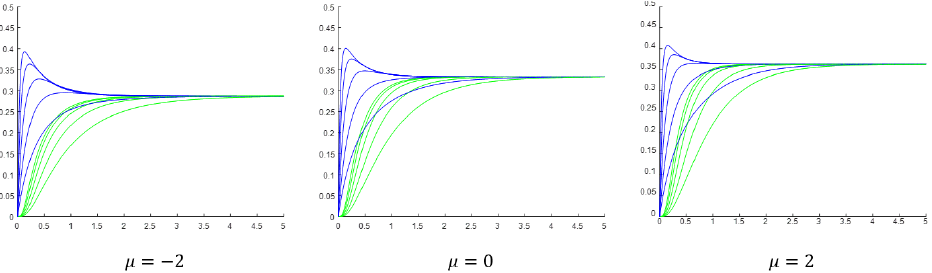
Figure 6. The dimensionless heat flux through the contact surface liquid–solid-body (blue) and through the right boundary (green) as a function of the time 𝜏 for Bi = 1 , a fixed ratio of 𝜏 𝑎 /𝜏 𝑐 = 1 , and 𝜏 𝑎 = 1, 1/2,1/4, 1/8,1/16 (the top blue and the top green curves correspond to 𝜏 𝑎 = 1/16 ). The thermal conductivity is 𝑔(𝜃) = 𝑒 𝜇𝜃 , 𝜇 = −2, 0, 2 .